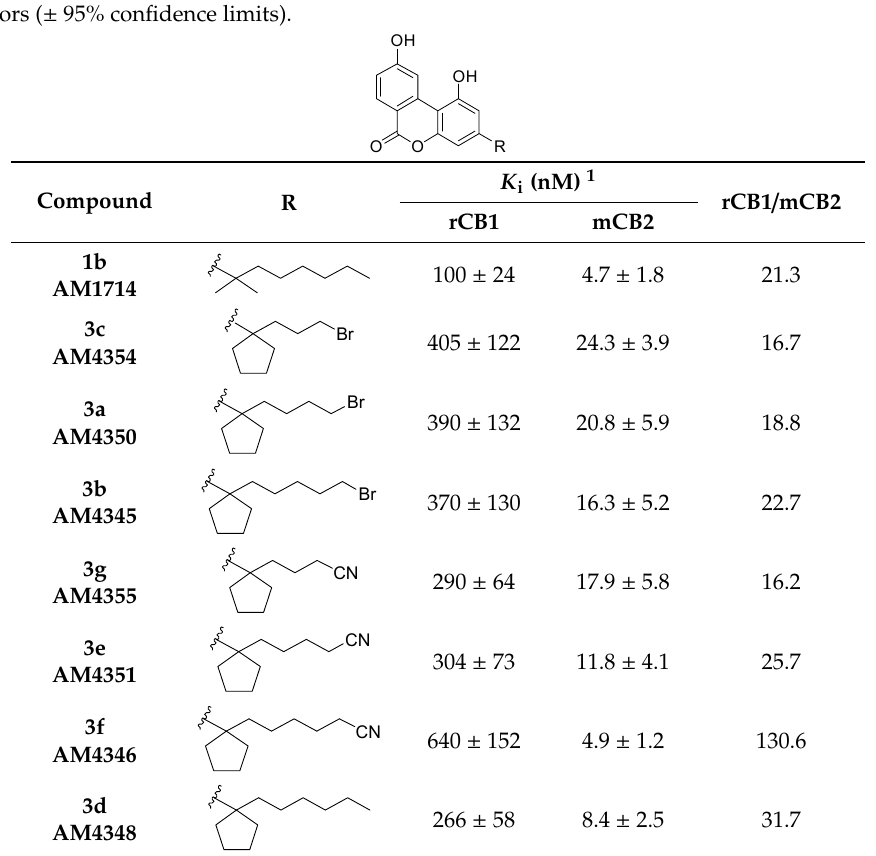
Table 2. Affinities of key cannabilactone analogs for hCB2 cannabinoid receptors (± 95% confidence limits).